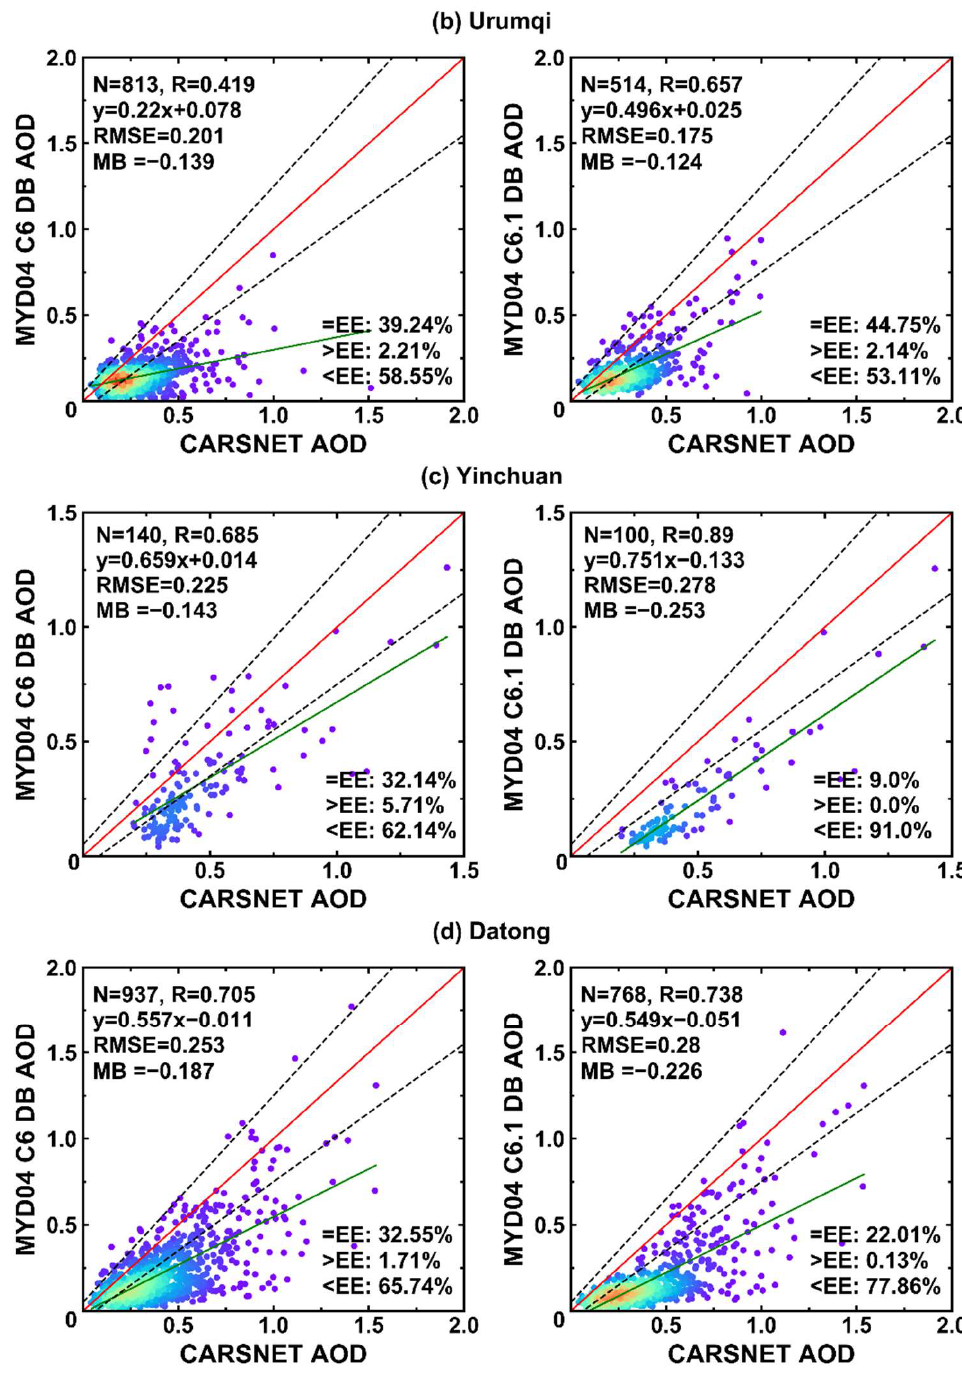
Figure 7. Validation of MODIS C6 ( left ) and C6.1 ( right ) DB AOD against ground-based AOD at 4 sites in urban and built-up region. One-one line, linear regression line, and the EE envelopes are plotted as red solid, green solid, and black dashed lines. ( a ) Lanzhou; ( b ) Urumqi; ( c ) Yinchuan; ( d ) Datong.